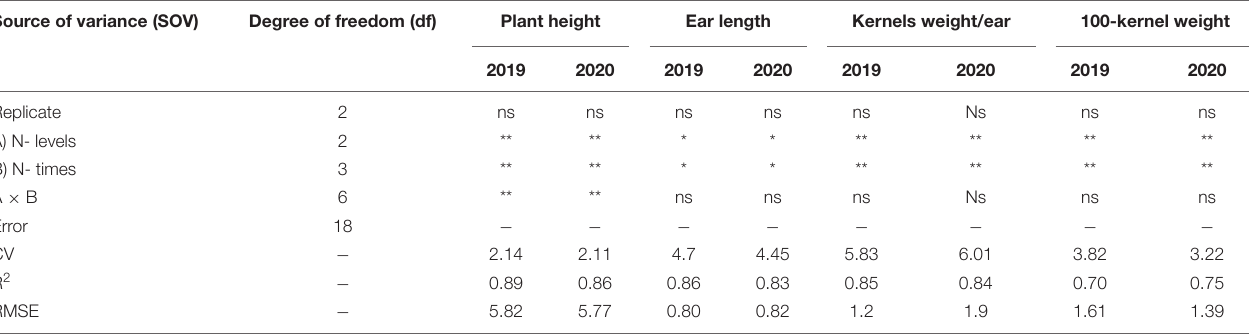
TABLE 3 | ANOVA of the effects of nitrogen rates and times of application and their interaction on plant height, ear length, kernels weight/ear, and 100-kernel weight of maize plants ( Zea mays cv. SC 10) in both seasons. Source of variance (SOV) Degree of freedom (df) Plant height